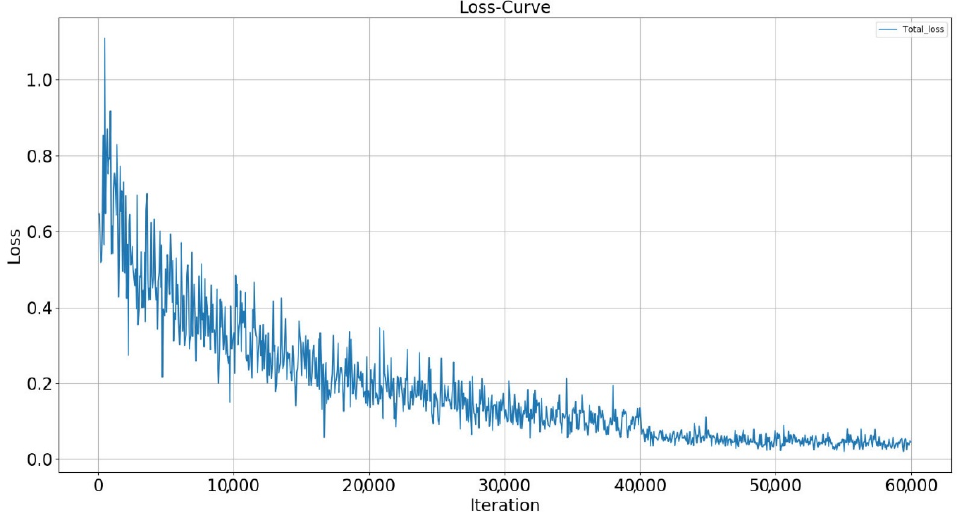
Figure 5. Loss curve of multi-scale feature network during the training process.